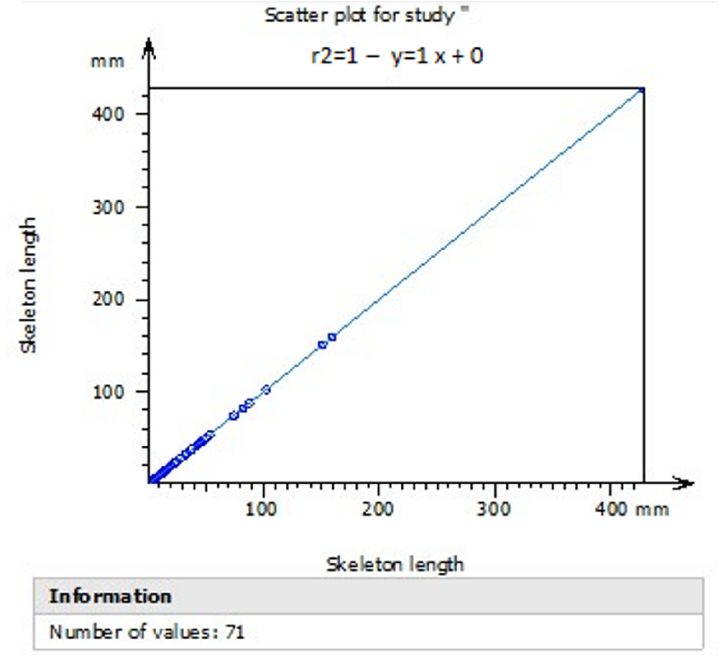
Figure 10. Determination coefficient R2. Table 1. Mean and standard deviation of TiO 2 scaffolds.